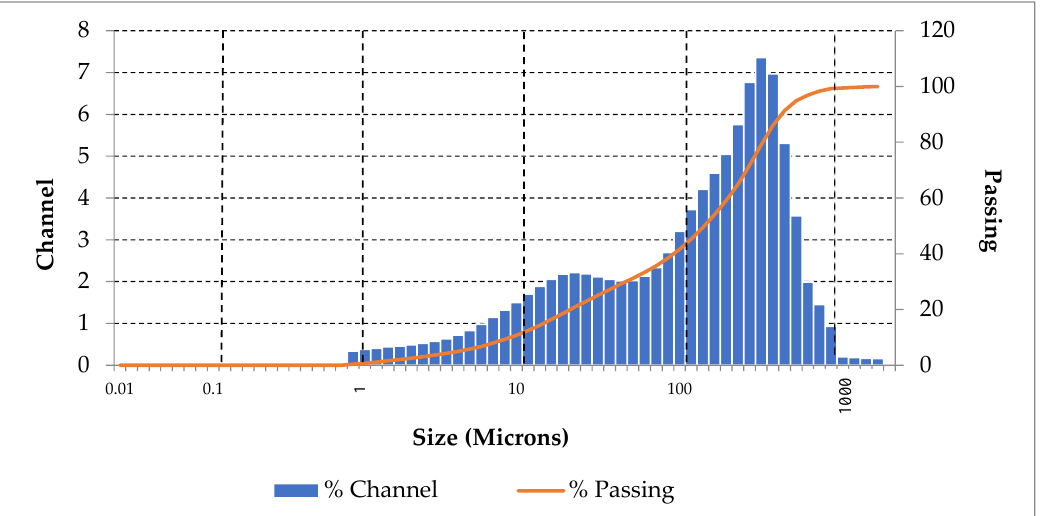
( c ) Figure 4. ( a ) Preparation of samples, ( b ) Flexural strength test, ( c ) Compressive strength test. Flexural strength (Rf):the sample was placed on two holders fixed at a distance of 10cm between them. The load was applied in the middle of these two holders above the sample. A three-point bend test was performed until the test sample bisects (Figure 4). This test aimed to determine the maximum resistance of the specimen under bending. Compressive strength (Rc):compression testing was determined by a portion of the specimen retained in the flexural strength test.